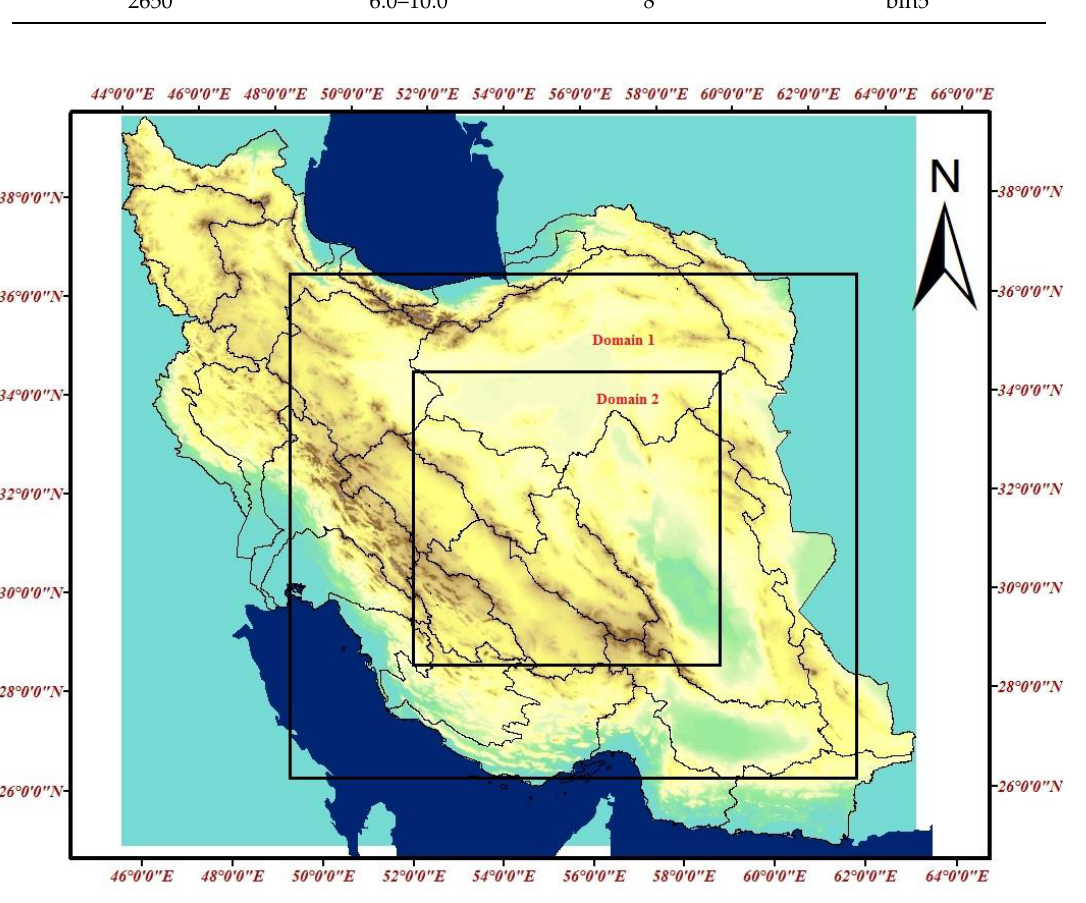
Figure 2. Two domains defined for the Weather Research and Forecasting model with chemistry WRF-Chem model.